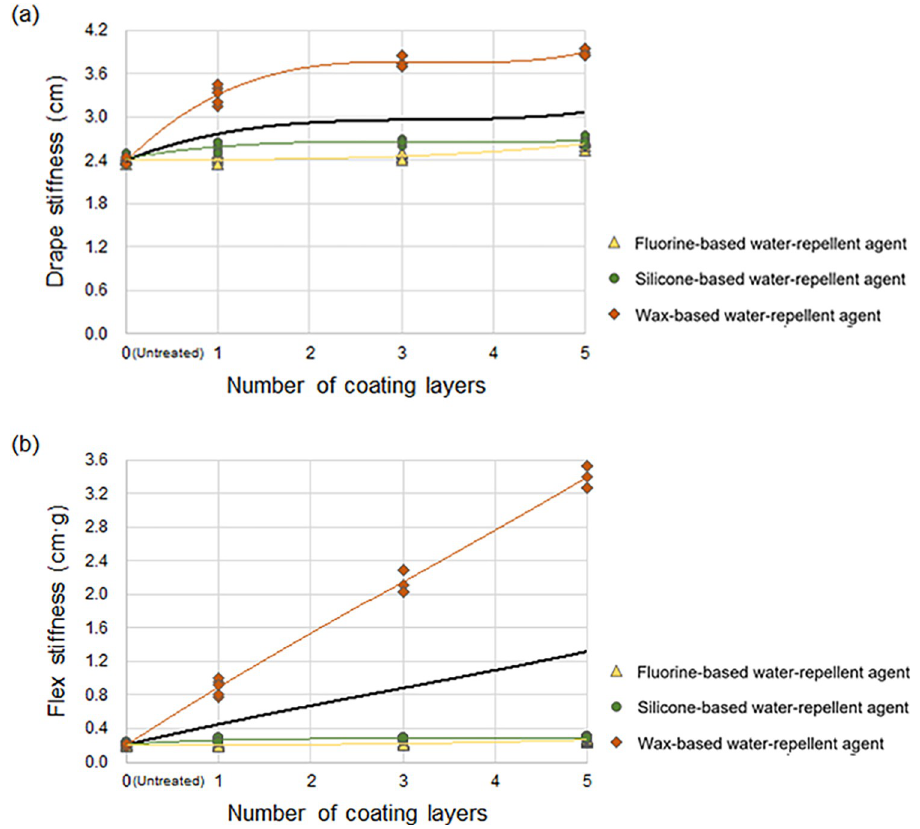
Fig 8. Stiffness of the cotton woven fabrics according to the number of coating layers of the water-repellent agents: (a) drape stiffness and (b) flex stiffness. The black line represents the trendline (third-order polynomial).